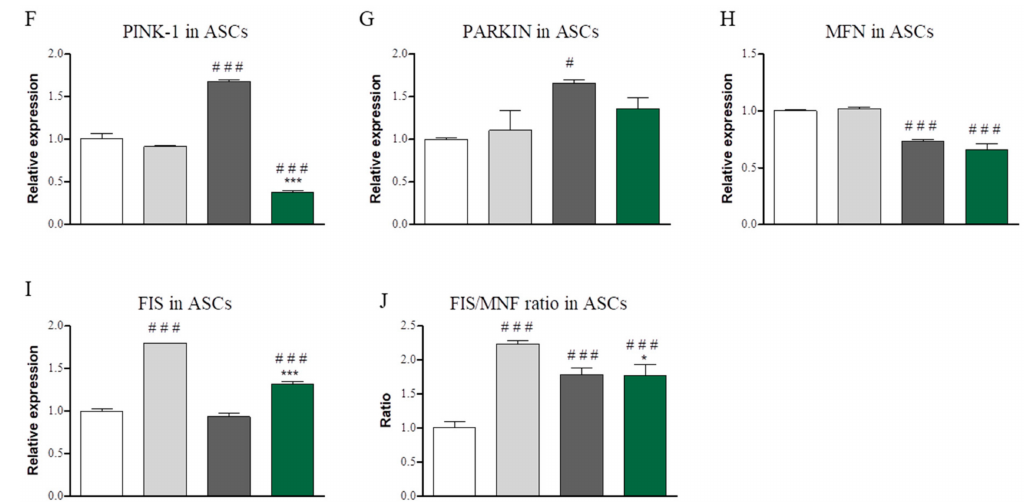
Figure 6. Evaluation of mitophagy-related genes after co-culture of ASCs with PBMCs. After co-culture expression of PINK-1 ( A ), PARKIN ( B ), MFN ( C ), and FIS ( D ) in PBMCs was evaluated using RT-PCR. Furthermore, the ratio of FIS/MNF ( E ) was calculated based on relative expression of both genes. The same genes: PINK-1 ( F ), PARKIN ( G ), MFN (H), and FIS ( I ) mRNA levels were established for ASCs. Similarly, ratio of FIS/MNF expression was calculated ( J ). Statistical significance was labelled with hash (#) when comparing to control group (ASC CTRL /PMBM CTRL ) and asterisk (*) when comparing to the EMS group (ASC EMS /PBMC EMS ). Results expressed as mean ± S.D. #, * p < 0.05; ## p < 0.01; ###, *** p <